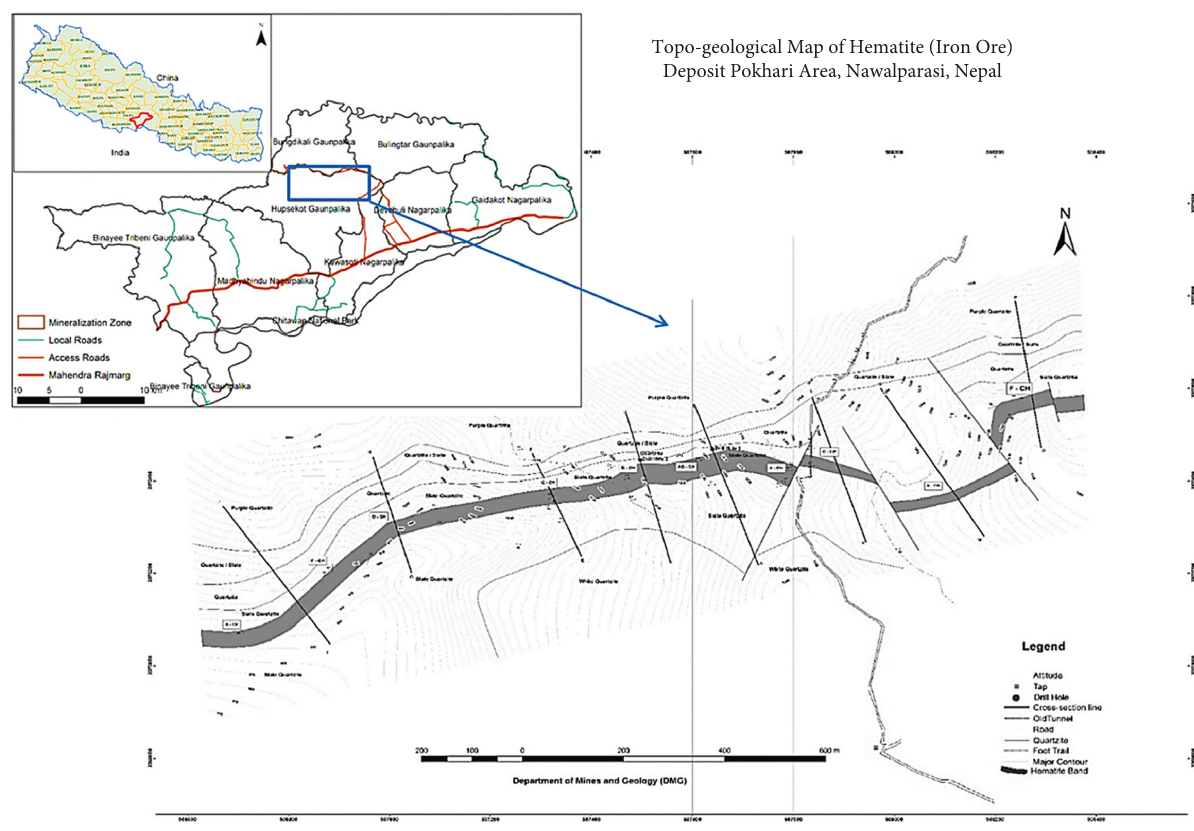
Figure 1: Topo-geological map of the sample collection site Pokhari, Nawalparasi, Nepal